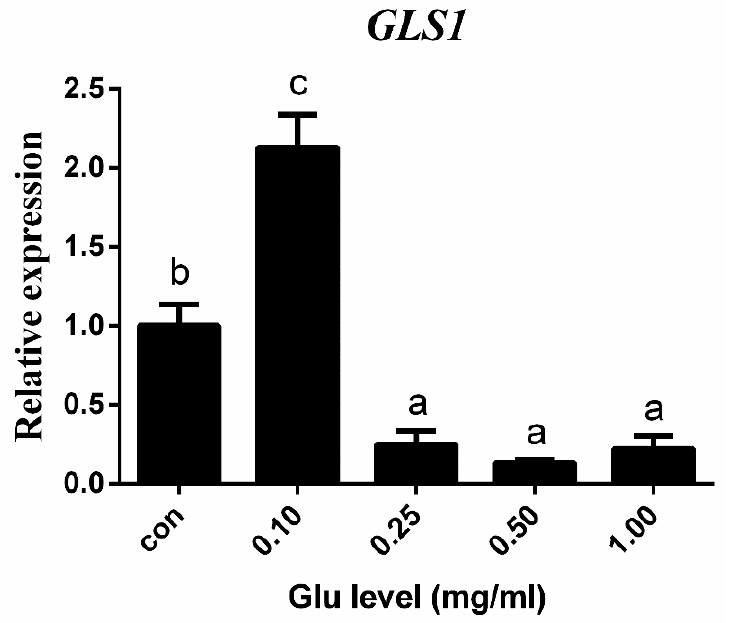
Figure 7. The effects of Glu on TCC gls1 gene expression in the primary culture muscle cells. Different letters represent significant difference ( p < 0.05, n = 9 for each bar).